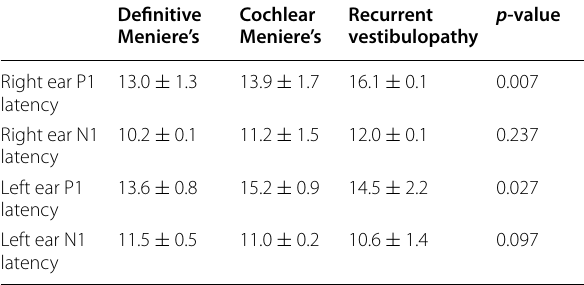
Table 13 o-VEMP P1 and N1 latencies in the left and right ear